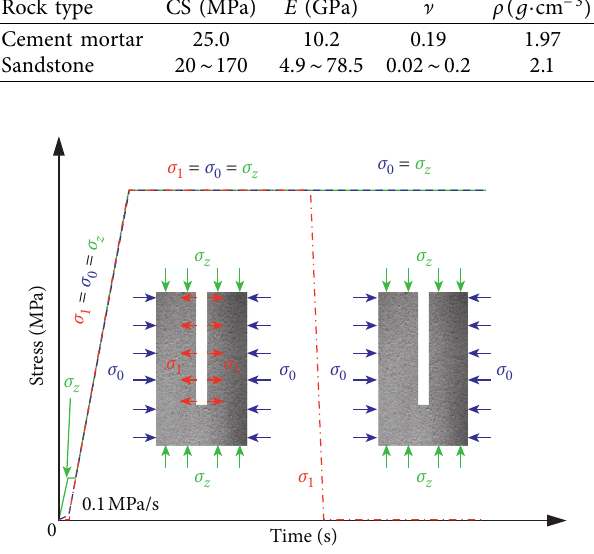
Figure 4: Loading, unloading paths, and stress combinations for the experimental process, where σ is the external confining stress, and σ z is the axial σ 0